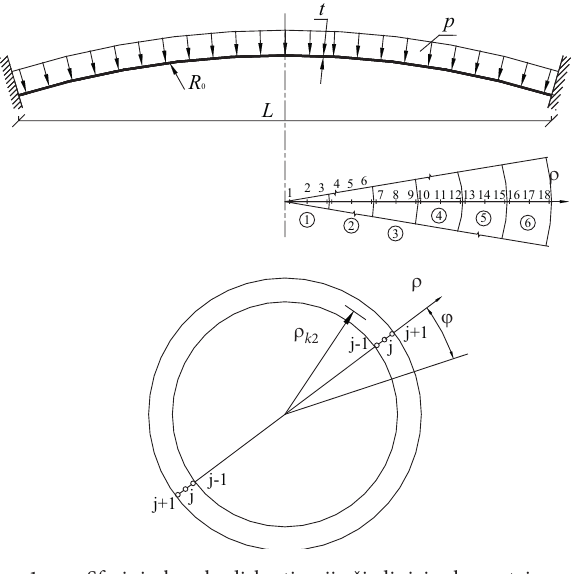
1 pav. Sferinio kevalo diskretizacija žiediniais elementais su trimis mazgais Fig. 1. Discretization of the flat spherical shell by circular elements with three nodal points